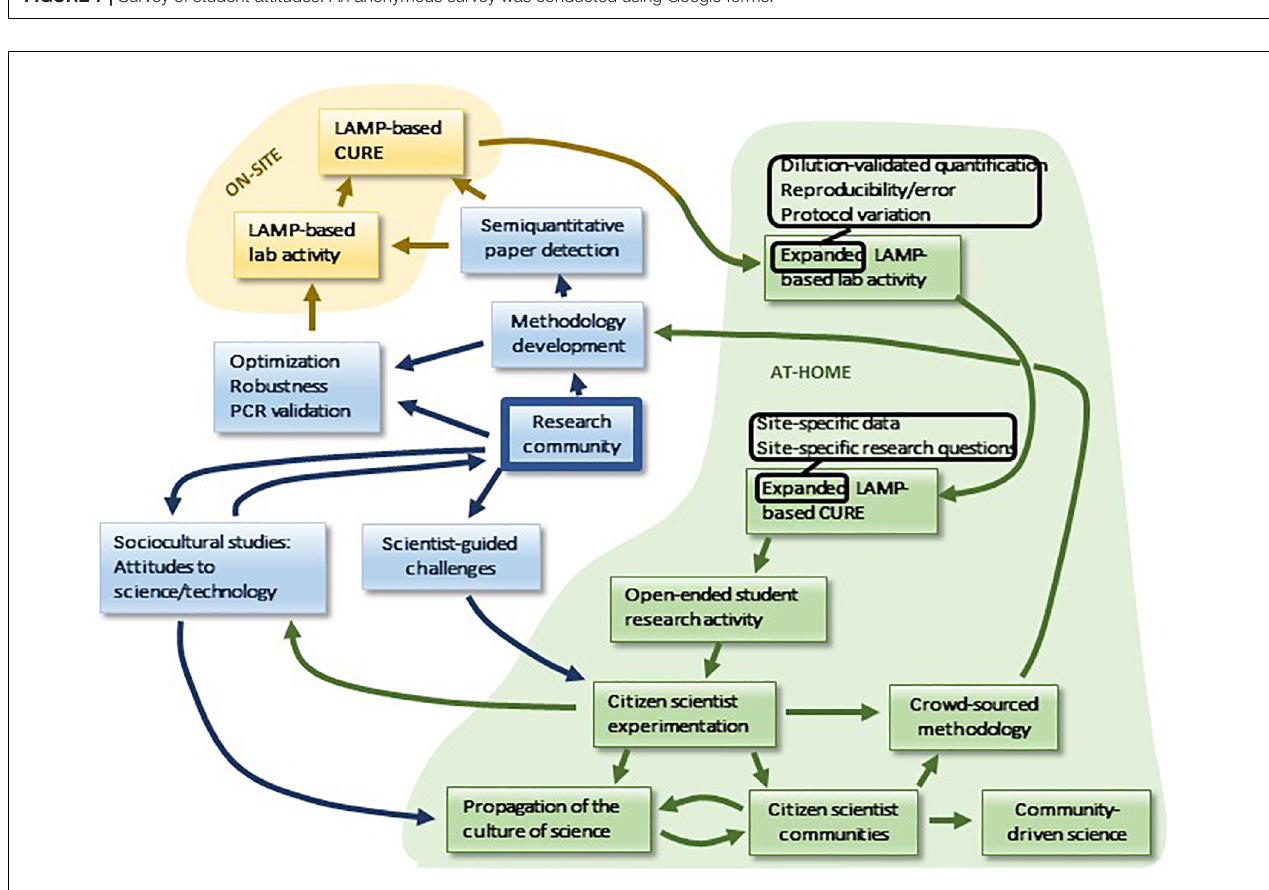
FIGURE 8 | A potential usage of LAMP in distance